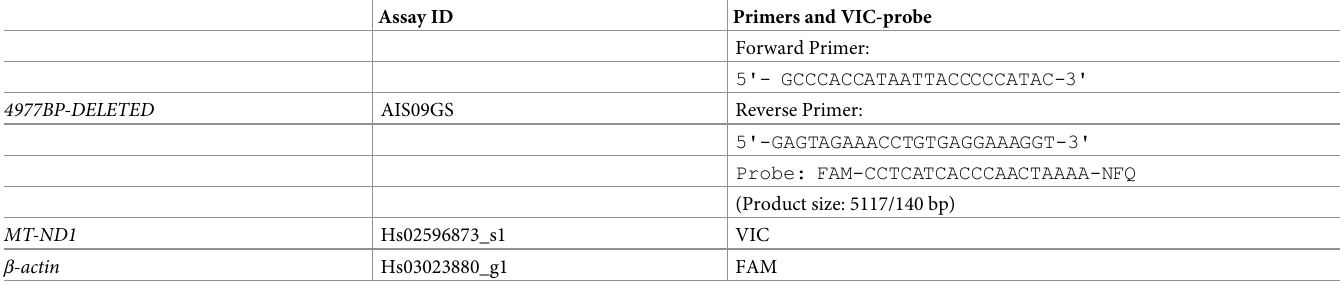
Table 2. Primers and TaqMan probes for real-time quantitative